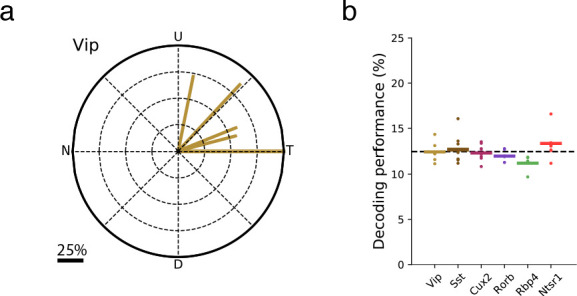
The direction of VIP neuron bias was consistent across mice and did not result from stimulus direction-selective running behavior.(a) Vector sums for each of the six Vip-Cre experiments. N: Nasal, T: Temporal, U: Up, D: Down. (b) Performance of a linear support vector classifier trained to decode the direction of grating (1-of-8 classification) from the running speed of the mouse. The average validation performance for three-fold cross-validation is shown. Each dot is the performance for one experiment; bars are the mean across experiments of a given Cre line.